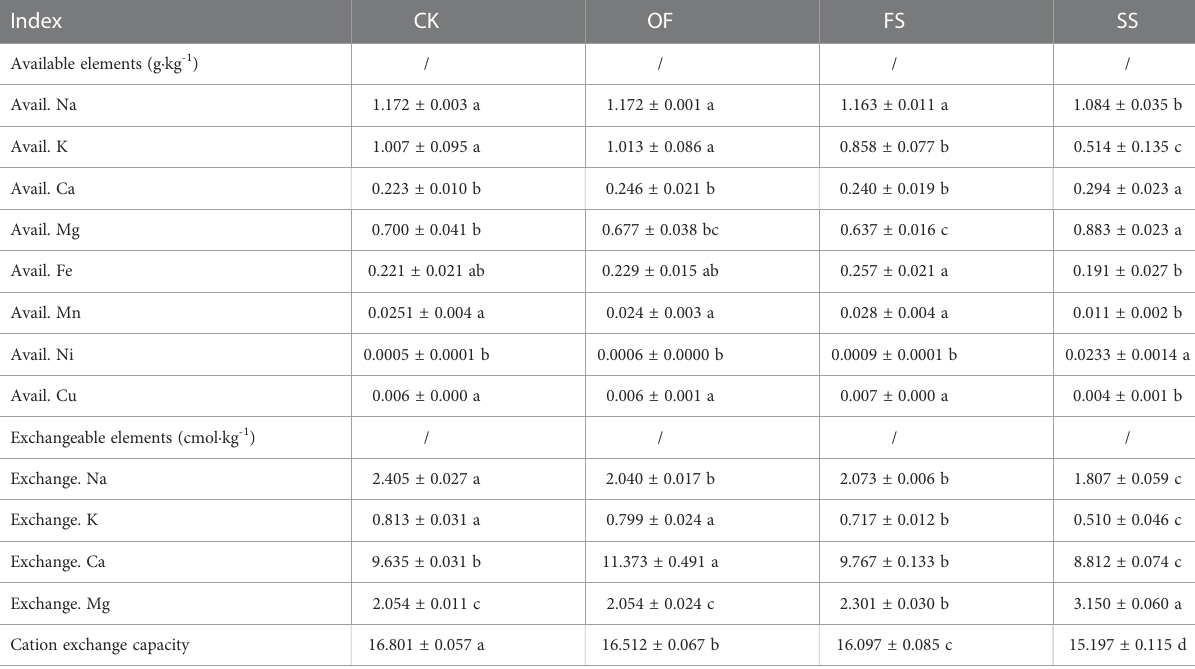
TABLE 2 Contents of base ions and trace elements in the soil surrounding S. cannabina grown in CSS with different